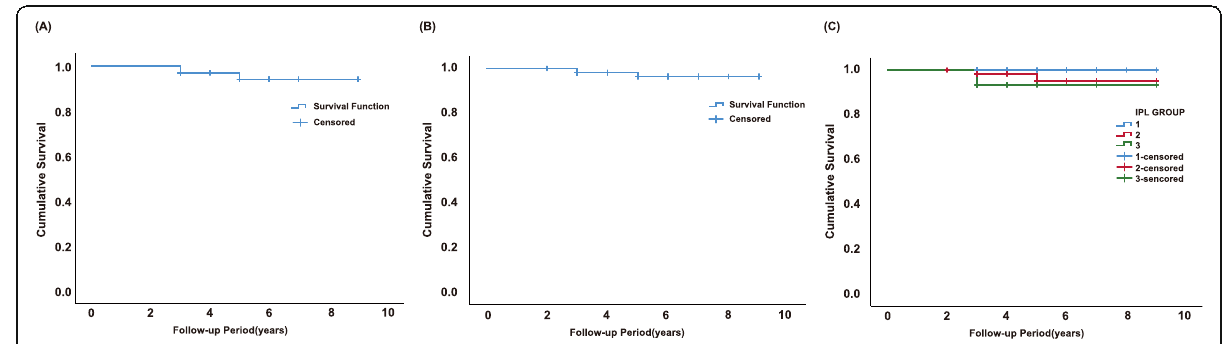
Fig. 2 ( a ) Patient-based and ( b ) implant-based Kaplan-Meier curve indicating favorable cumulative survival rates for non-grafting OSFE. ( c ) Kaplan- Meier analysis of implants with different IPL groups at the baseline. High implant survival rates were shown and no significant difference was found between the three IPL groups ( P